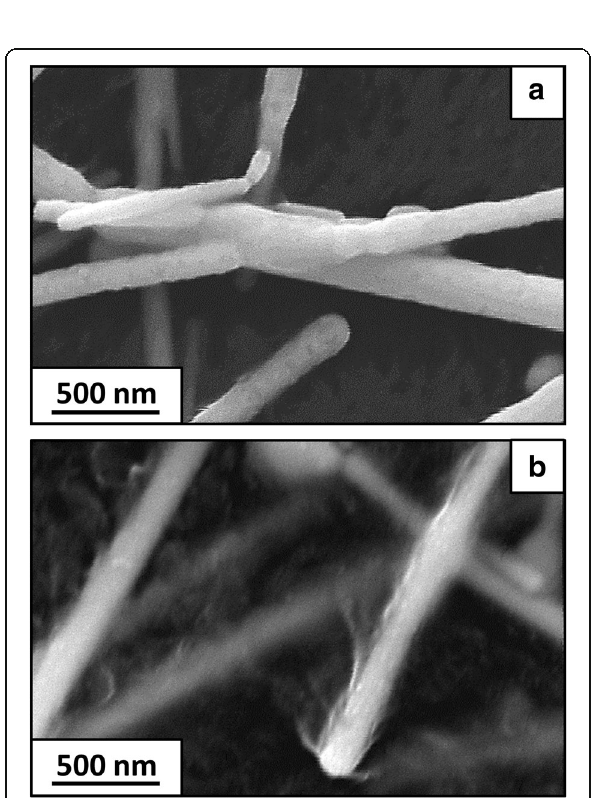
Fig. 3 SEM images of thermally treated, PET-supported TCEs. a Fused (TCE #1, 220 °C/1 h). b PET-encapsulated (TCE #2, 230 °C/1 h) Cu